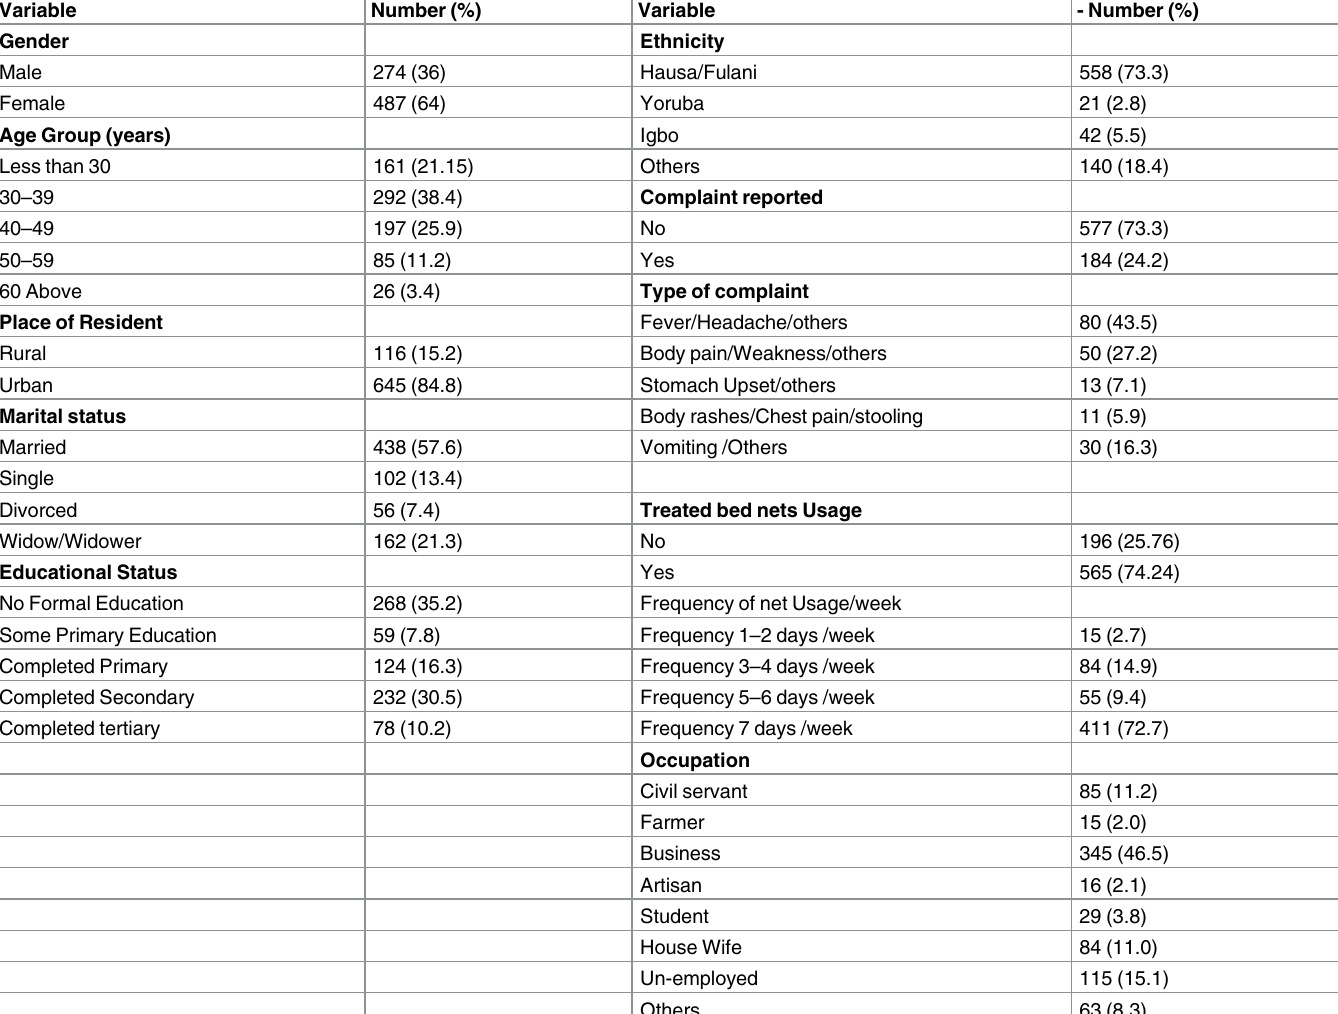
Table 1. Baseline Characteristics of HIV Patients Attending ART Clinic at Infectious Disease Hospital Kano Between June to December2015 (n =